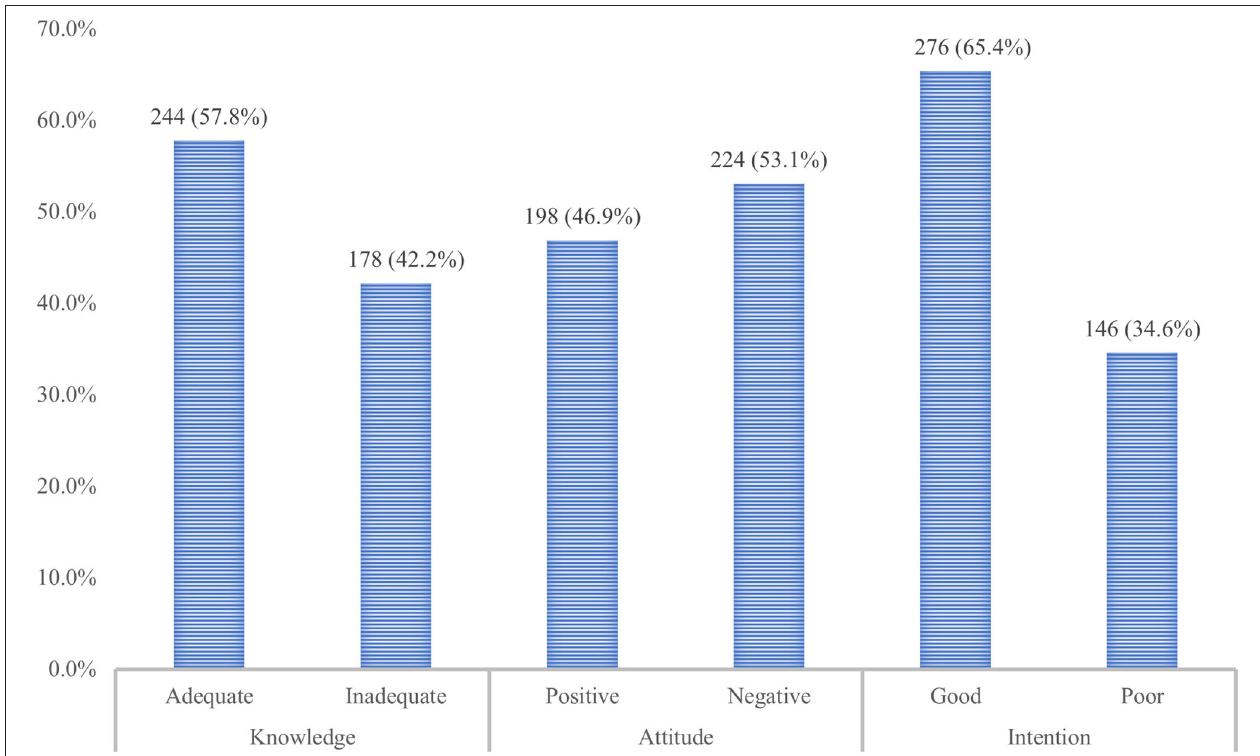
FIGURE 1 | The overall breastfeeding knowledge, attitude, and intention of pregnant women attending the MCH clinic of DTCSH in Debre Tabor, Northwest Ethiopia, 2022.